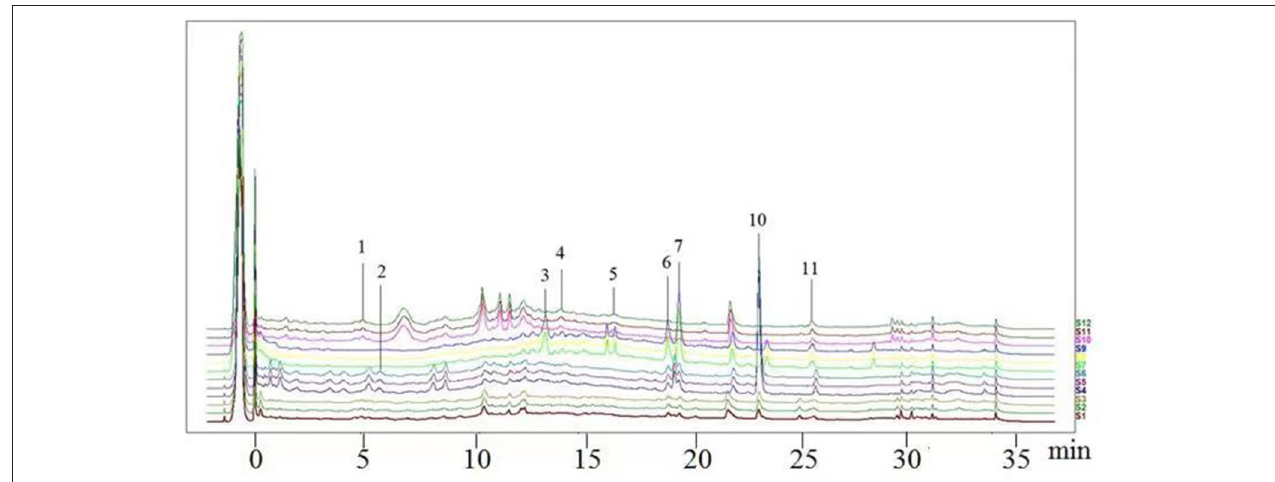
FIGURE 3 | The overlapping HPLC characteristic chromatograms of the four Dendrobium samples. S1–S3: D. chrysotoxum ; S4–S6: D. fimbriatum ; S7–S9: D. nobile ; S10–S12: D. huoshanense . D. huoshanense, Dendrobium huoshanense; D. nobile , Dendrobium nobile; D. chrysotoxum , Dendrobium chrysotoxum ; D. fimbriatum , Dendrobium fimbriatum ; HPLC, high-performance liquid chromatography.